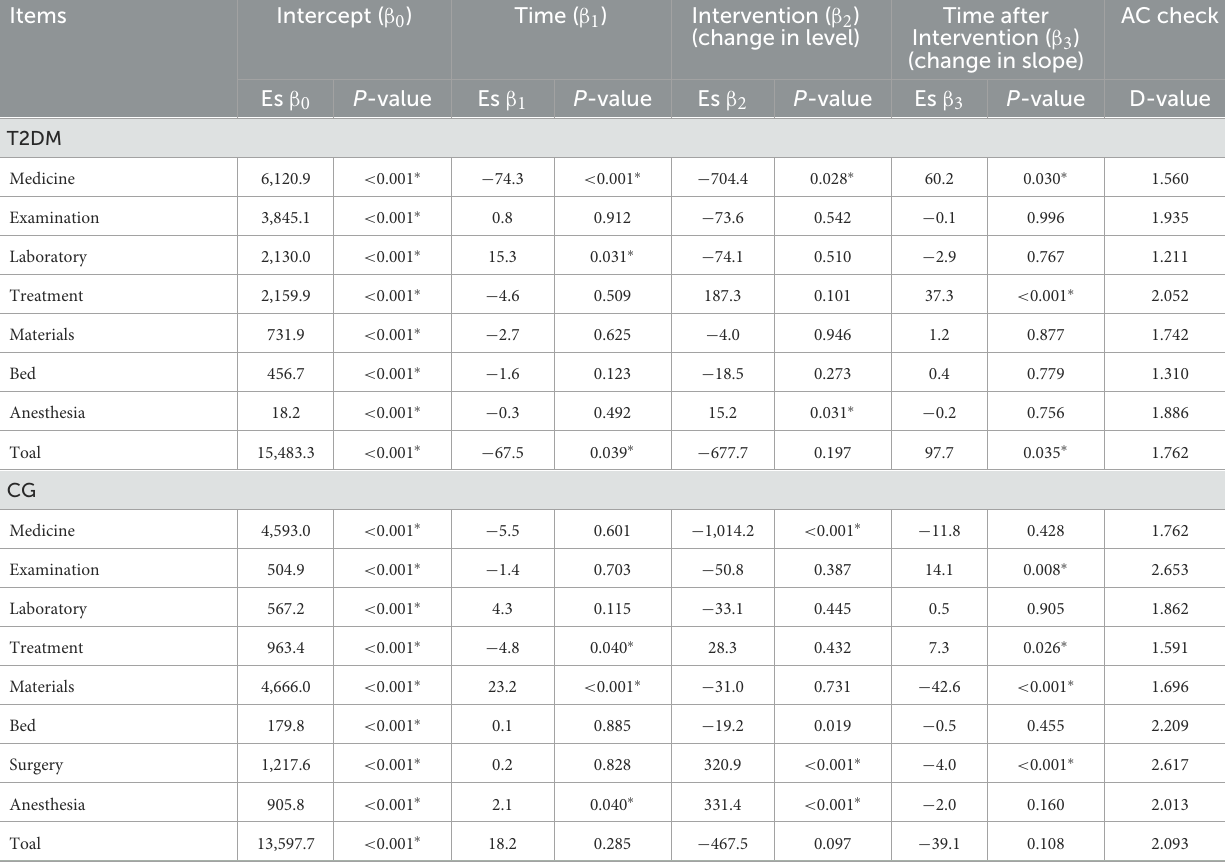
TABLE 5 Model validation and parameter estimation of average medical expenses for two